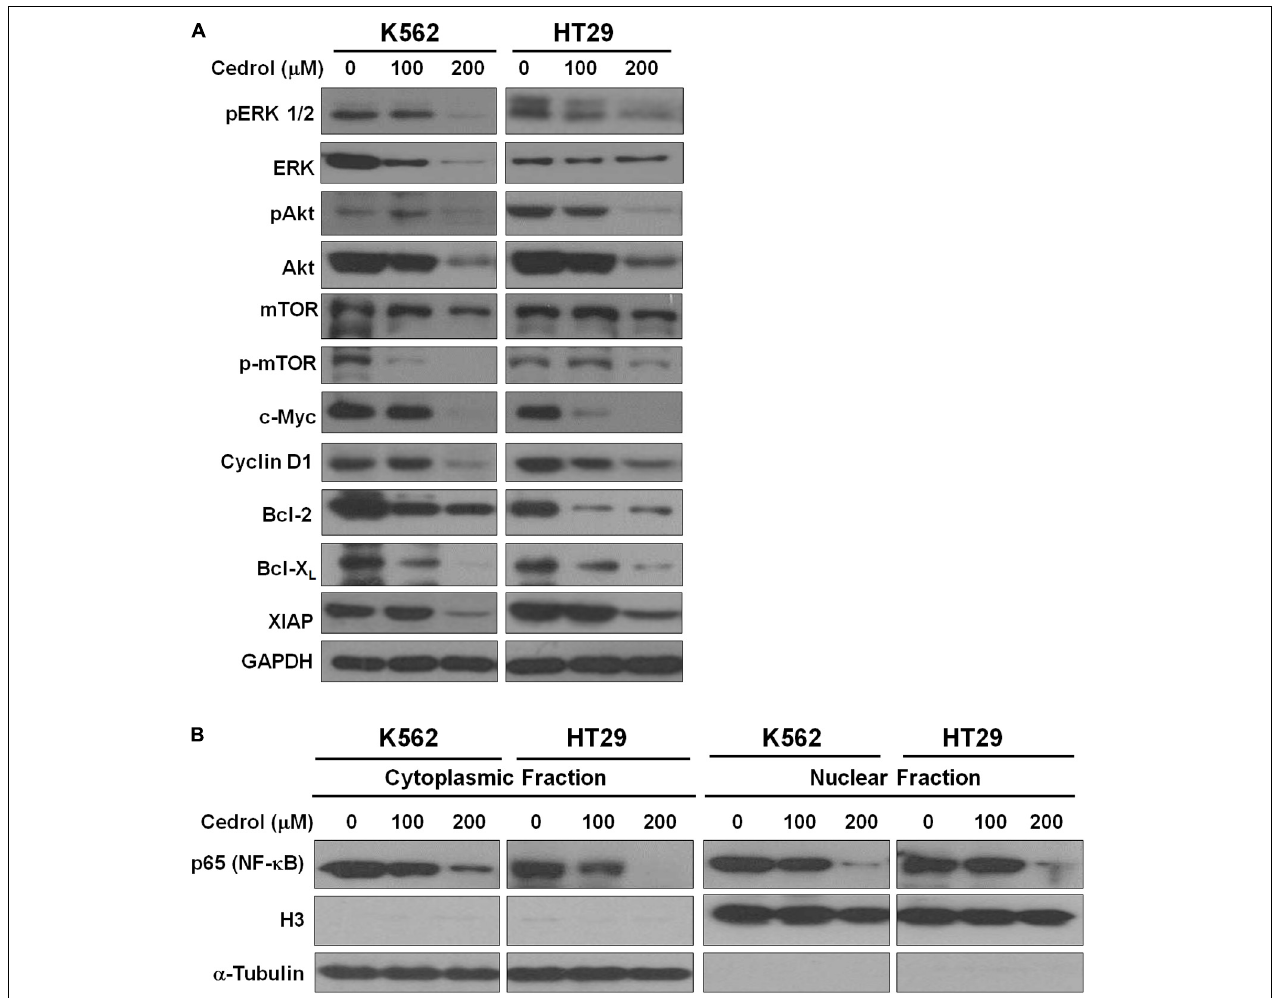
FIGURE 3 | Cedrol inhibited the levels of proteins in pro-survival signaling pathways. (A) K562 and HT29 cells were treated with either VH or cedrol for 18 h. Proteins were isolated, and Western blotting for proteins related to cell survival signaling and apoptosis was performed. (B) K562 and HT29 cells were treated with either VH or cedrol for 18 h. Cytosolic and nuclear protein lysates were isolated and Western blotting for the NF- κ B-p65 subunit was performed. Histone protein H3 and GAPDH were detected as a loading control in nuclear and cytoplasmic lysates,